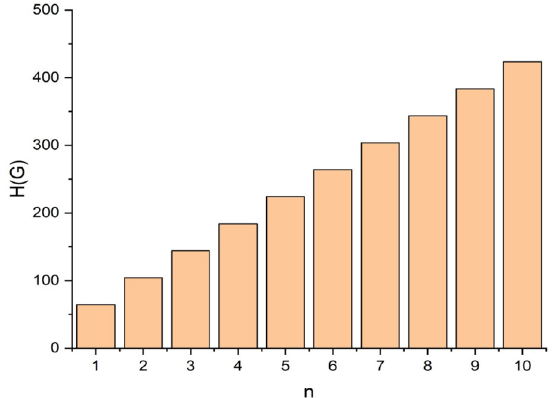
Figure 12. The comparison of n and . H ( G )